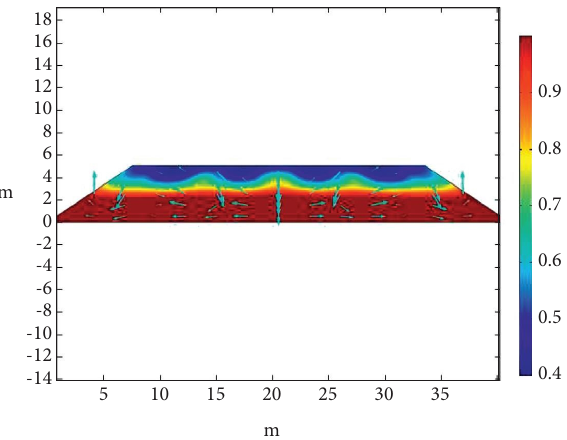
Figure 19: Darcy velocity feld of embankment soil on the fourth day.